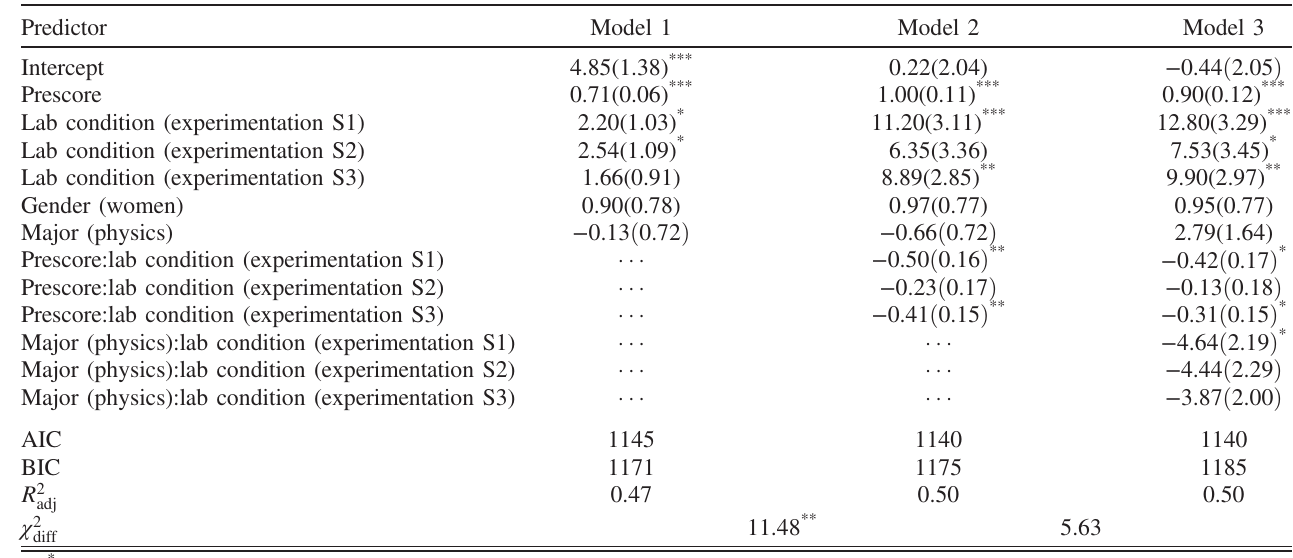
TABLE XIV. Regressions performed on the outcome of postscore on the E-CLASS including semester 1 (S1), semester 2 (S2), and semester 3 (S3). The base comparison is lab condition (content-reinforcement S1), gender (men), and major (nonphysics). Statistical comparisons demonstrate that models 2 and 3 are statistically equivalent and better fits to the data than model 1. There are 191 matched E-CLASS responses included in this